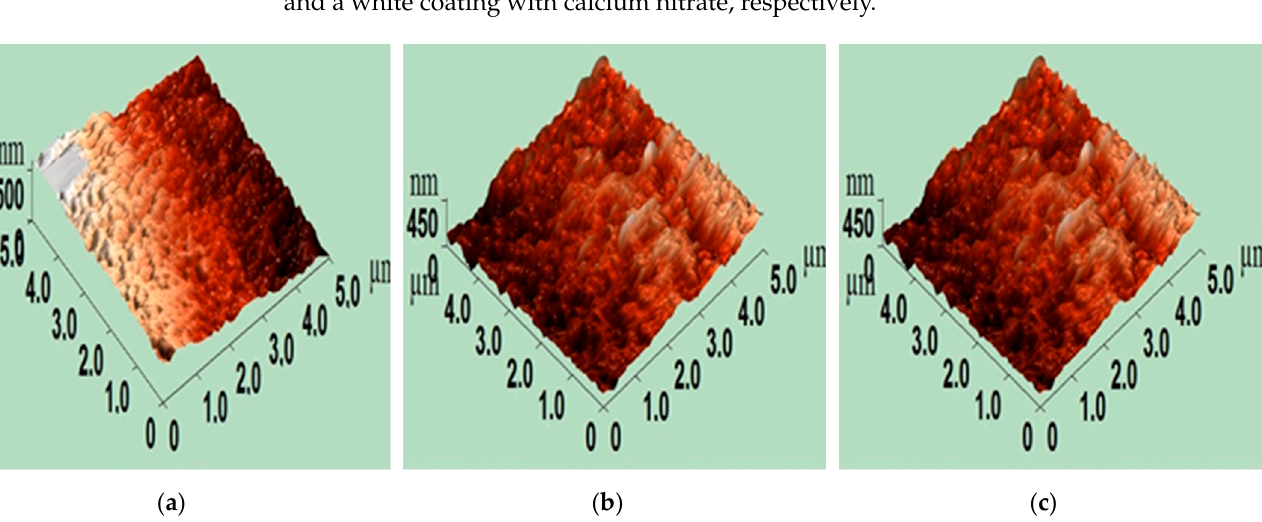
Figure 3. Images of the surface of phosphate coatings from the SolverP47-PRO atomic force micro- scope: ( a ) Coating from a modified solution; ( b ) Coating from a solution with the addition of zinc